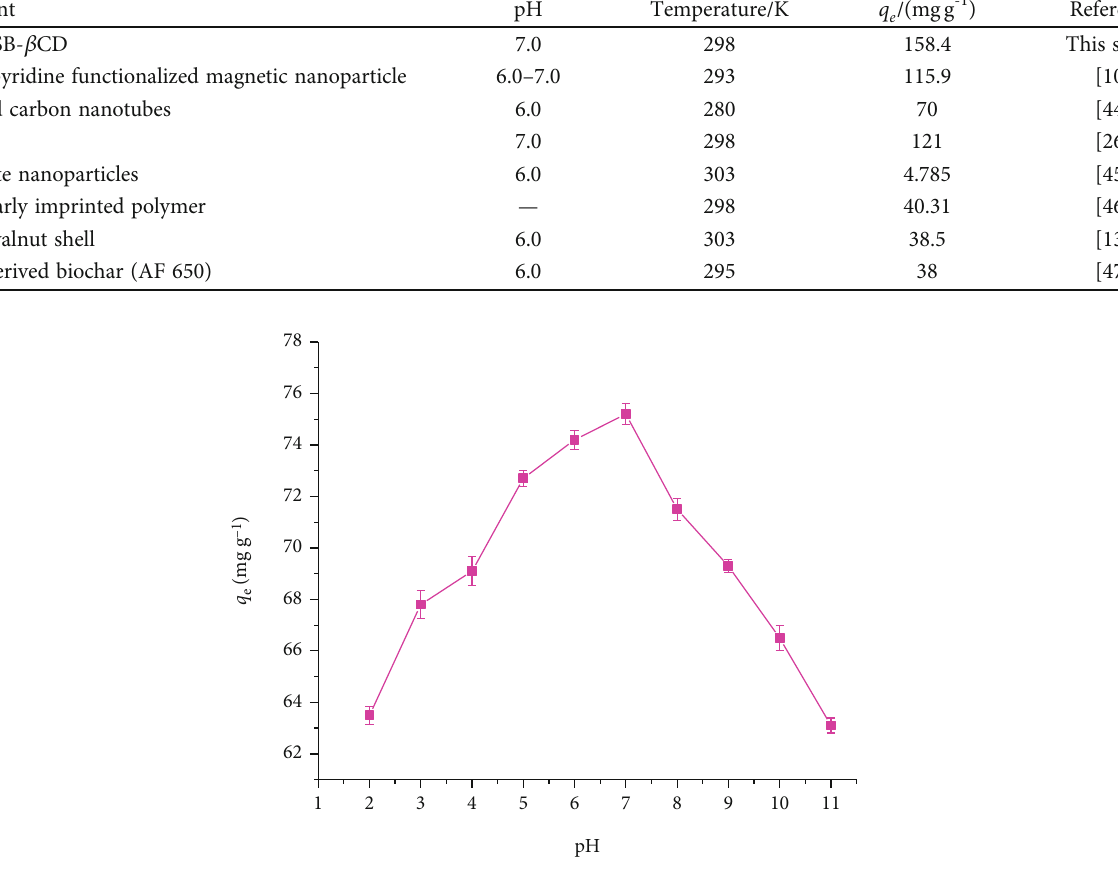
= 100 mgL -1 , V = 10 mL, m = 0 : 01 g, T 0